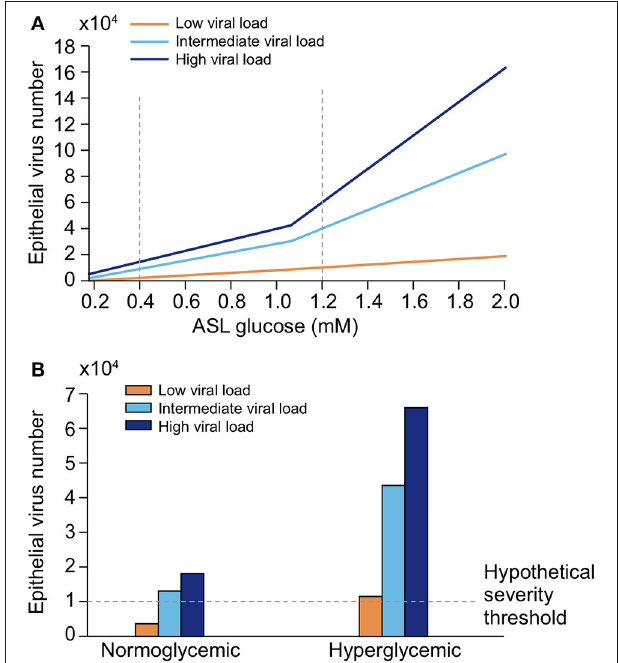
FIGURE 23 | Simplified computational model of SARS-CoV-2 replication rate as a function of glucose concentration in the ASL and viral load at time of a sneeze stimulus. (A) The dynamic of the viral replication, in case of three different viral load (low, intermediate, and high, see section Methods), as a function of a sweep over a range of glucose concentrations in ASL was computed and represented. (B) The values of viral replication rate in a normoglycemic (0.4mM ASL glucose) or hyperglycemic case (1.2mM ASL glucose) after a low, intermediate, or high viral load at time of infection are deduced from the model [see dashed line in (A) ] and plotted.